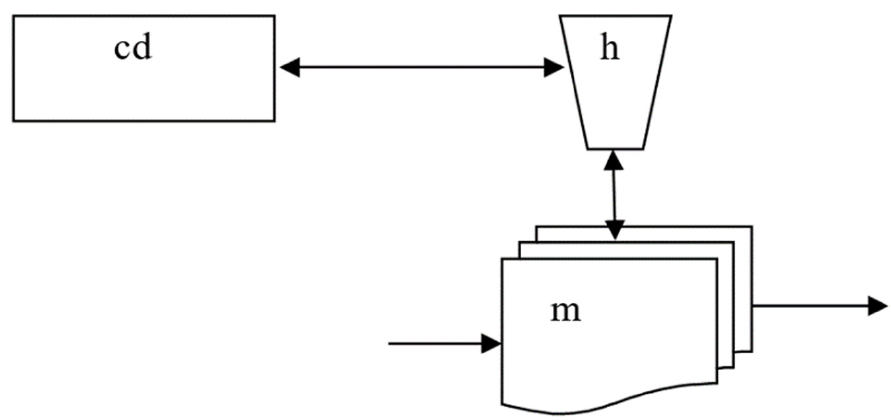
Figure 3. A schema of a Turing machine.